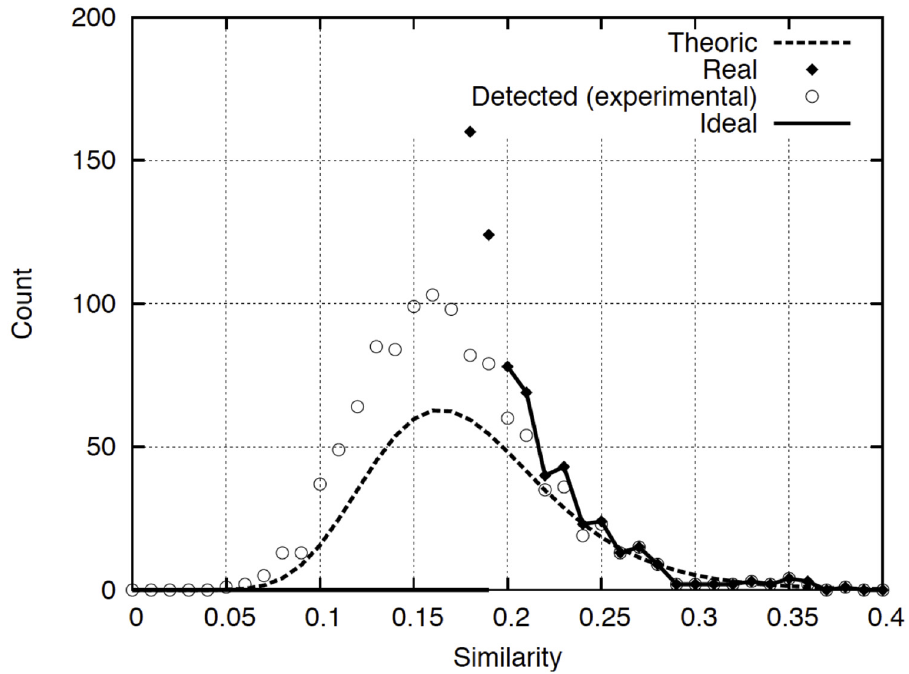
Fig 13. Number of positive identifications from a database with 2.56 (cid:129) 10 6 particles when s min = 0.2.